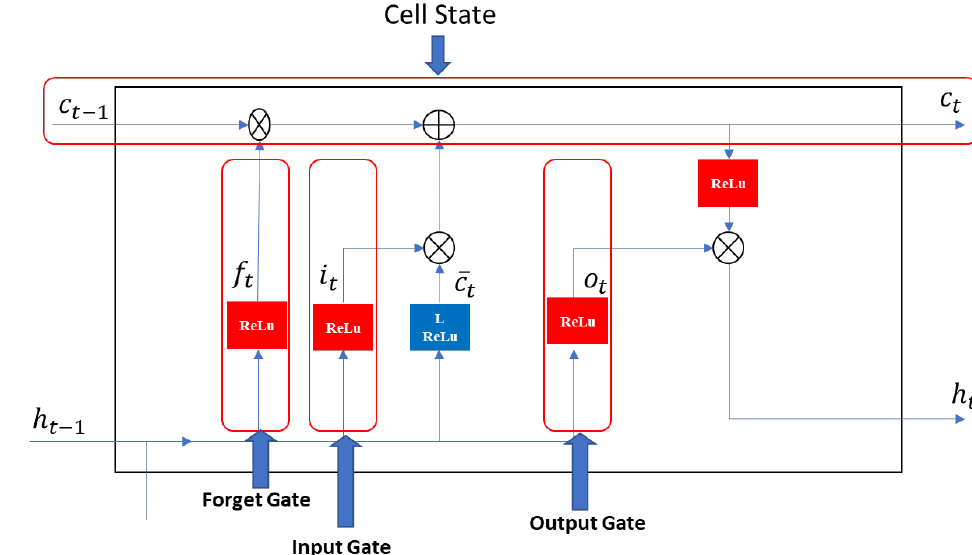
Figure 3. Pictorial description of proposed LSTM cell. Algorithm 1: # This algorithm separated the electricity load dataset into training, validation and testing sets